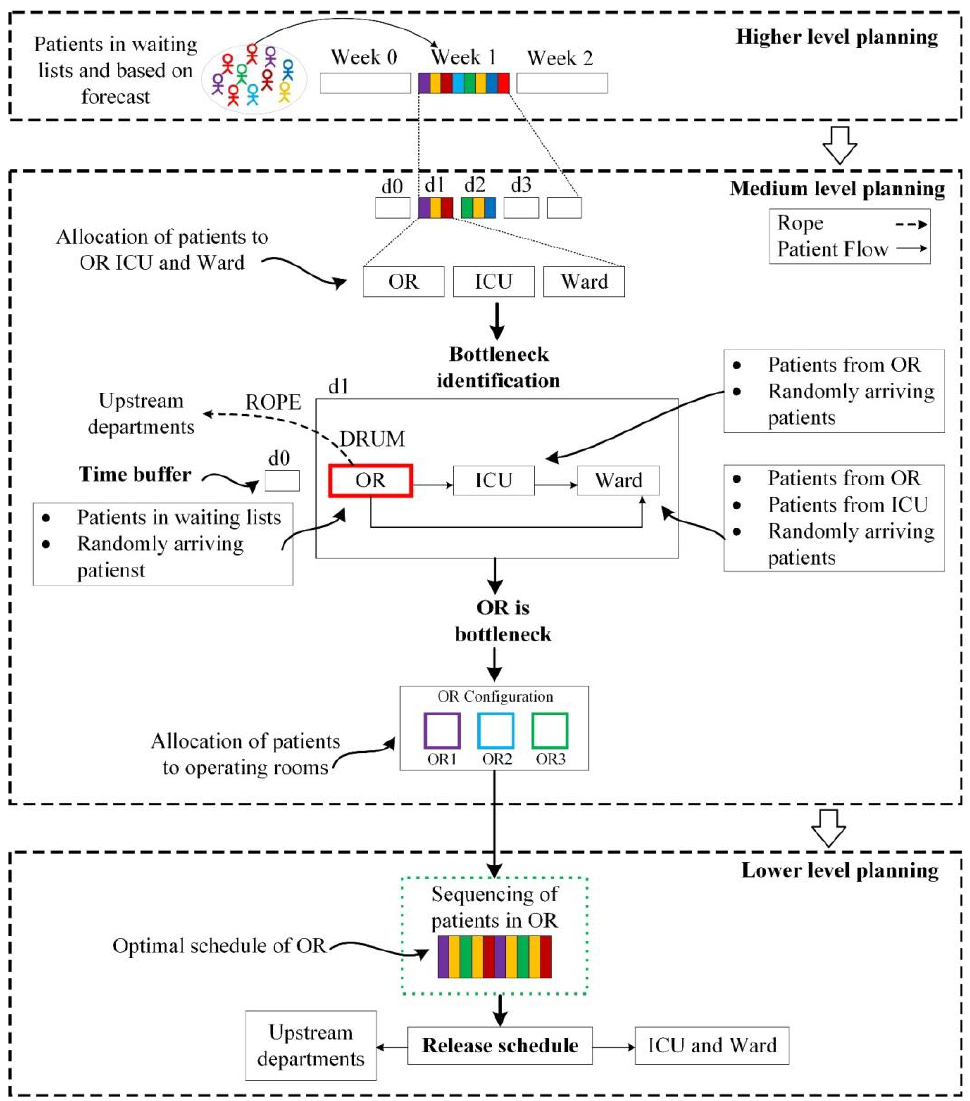
Figure 3. Multi-level integrated planning when the operating room is the bottleneck.